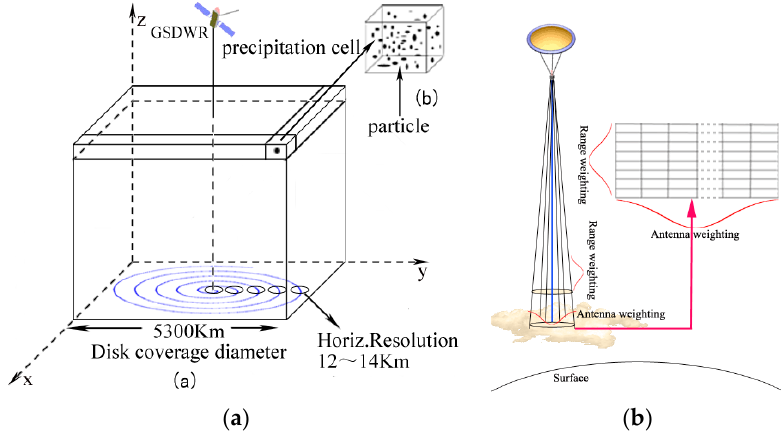
Figure 6. ( a ) The spatial distribution of the precipitation particles model and ( b ) the antenna weighted and distance weighted schemes.